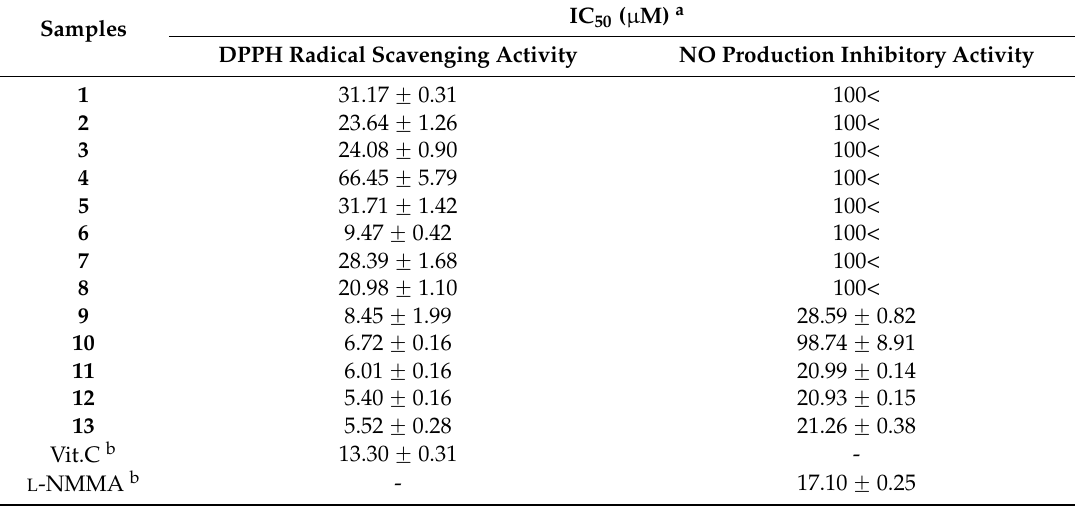
Table 1. IC 50 values of compounds 1 – 13 against scavenging DPPH radicals or inhibition of NO production on LPS-stimulated RAW264.7